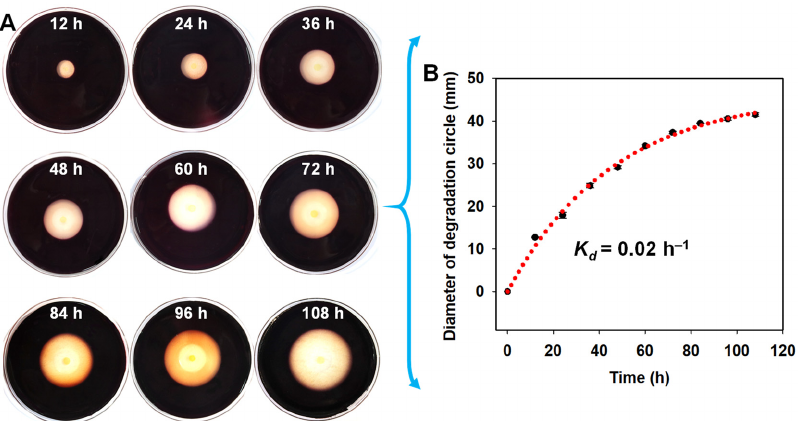
Figure 3. The agar-degrading capacity of A. macleodii QZ9-9. ( A ) Characterization of agar-degrading activity of A. macleodii QZ9-9 on the mineral salts agar plates (stained with Lugol’s iodine solution) at different degradation periods. ( B ) Kinetics of agar degradation by A. macleodii QZ9-9. Note: The data were fitted according to the first-order rate equation Y t = Y 0 + a(1 − e − kx ), where Y t and Y 0 are the degradation fraction at a given culture time t and 0 min, respectively; a is the fitting coefficients; and k is the observed rate constant.